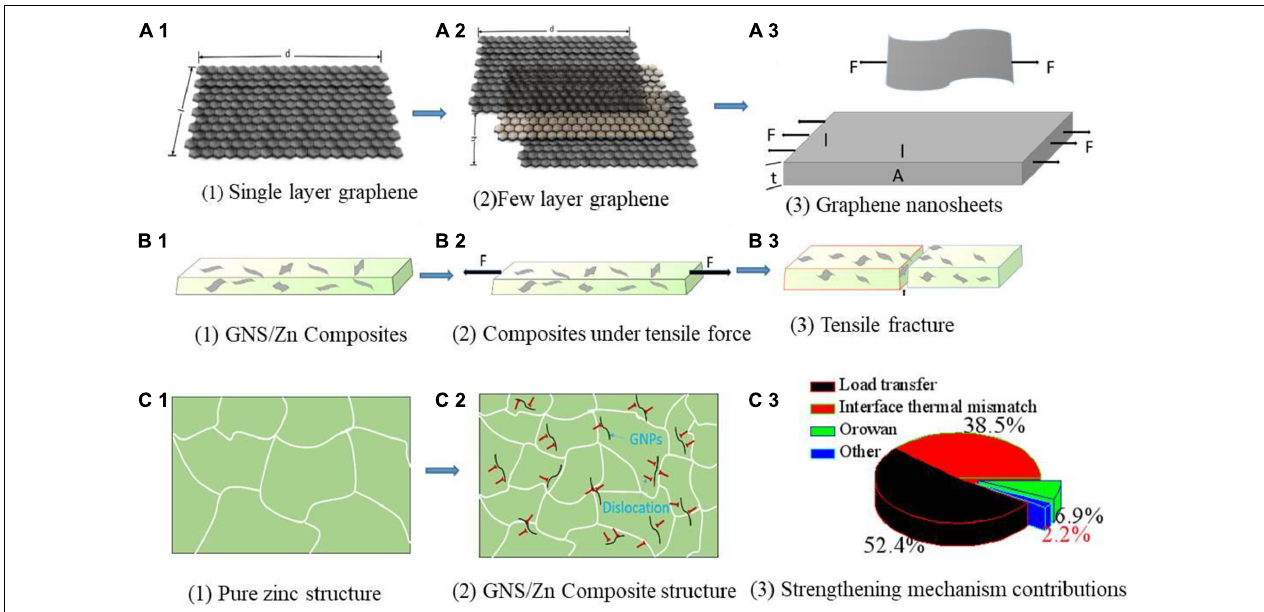
FIGURE 8 | GNS/Zn composite tensile physical model (A1–B3) , tissue evolution process (C1,C2) , contribution diagram of strengthening mechanism (C3).